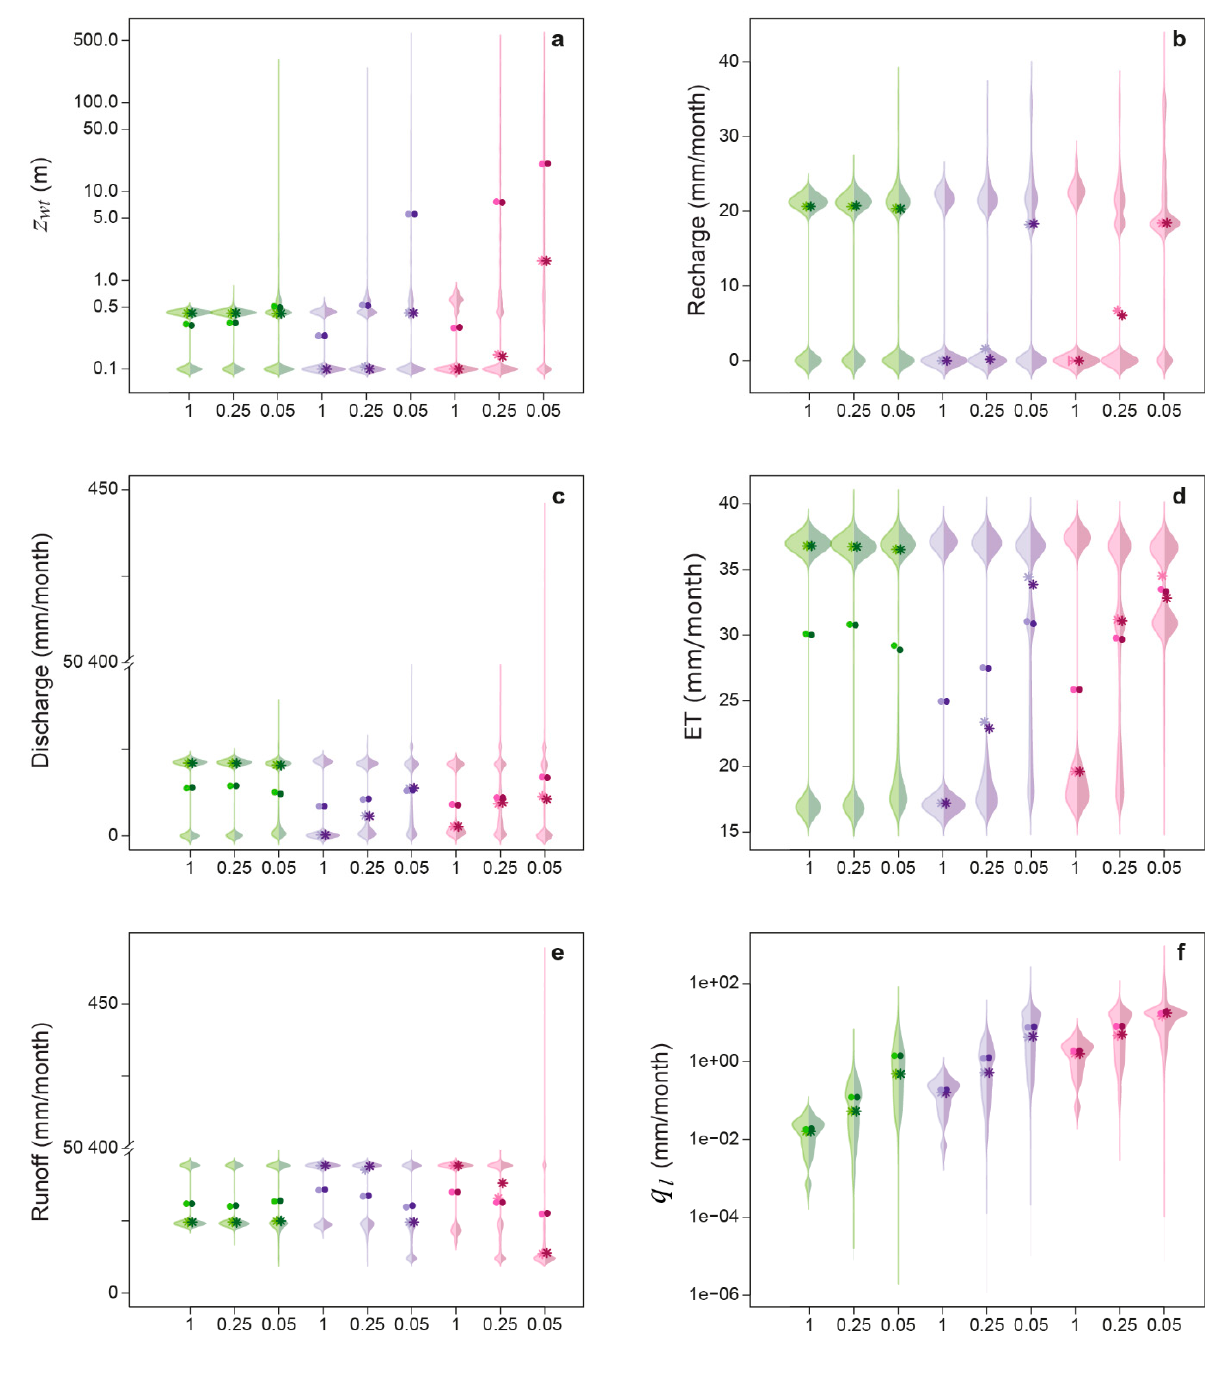
Figure 7. Distributions of water table depth and cell-mean fluxes for different grid resolutions and aquifer parameterisations. Note the broken axis (c, e).